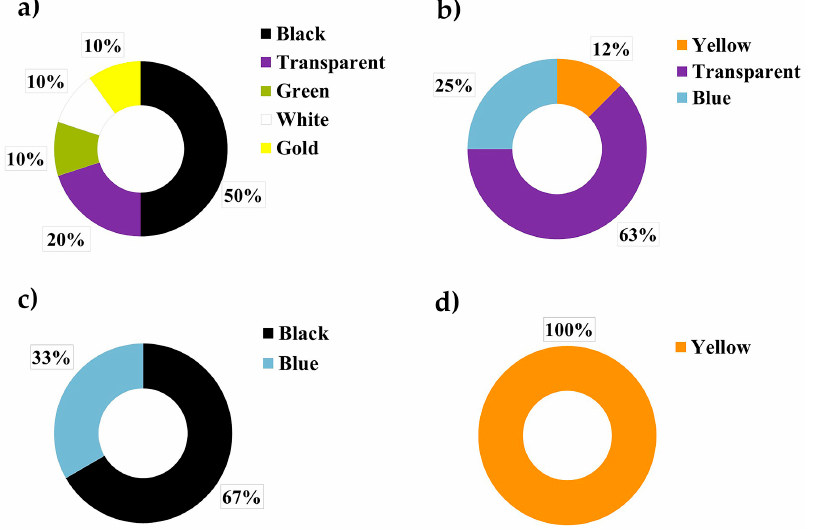
Figure 7. The percentages of different colours of MPs in the AS, Antarctica: ( a ) family Nototheniidae; ( b ) family Channichthyidae; ( c ) family Artedidraconidae; ( d ) family Zoarcidae.